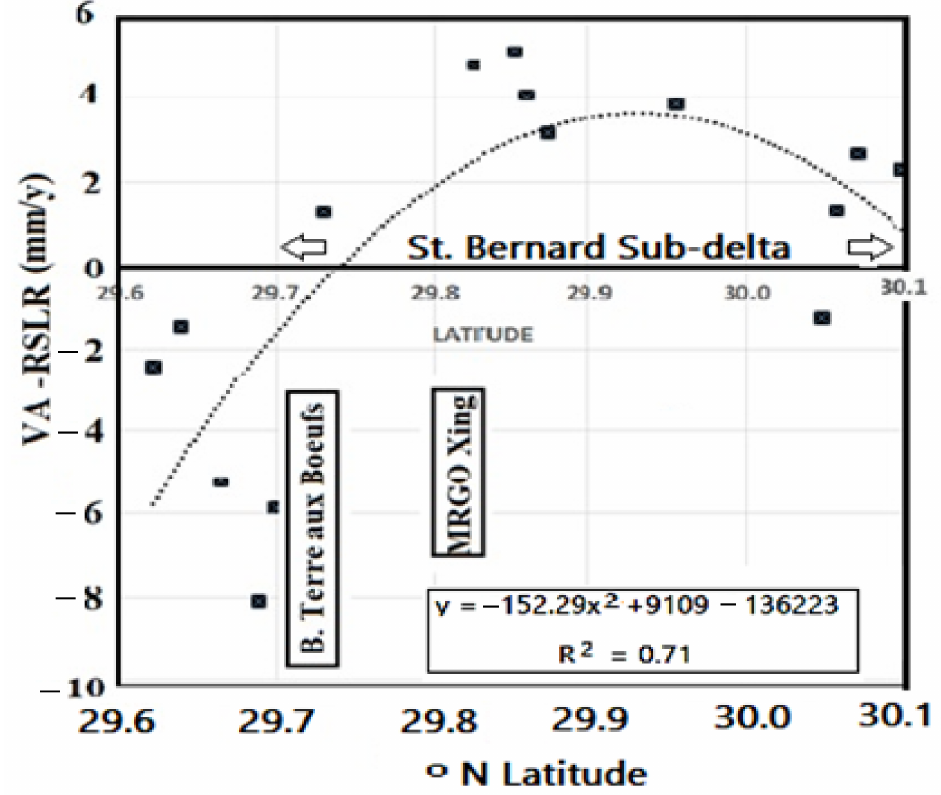
Figure 14. Relative Marsh Sustainability (VA—RSLR) averaged over the 2008–2018 decade with Latitude on CRMS Transect (Figure 3, Table S3). Points north of 29.7 ◦ are within the St. Bernard/Terre aux Boeufs sub-delta footprint while those south are from the younger Plaquemines/Balize sub-delta. Jankowski et al. [69] introduced use of a marsh vulnerability chart with VA plotted against RSLR (Figure 15). Delta marshes fall into one of two fields divided by the 1:1 line, with a 2 mm buffer zone. All Biloxi Marsh CRMS sites plot in the ‘Accretion Surplus’